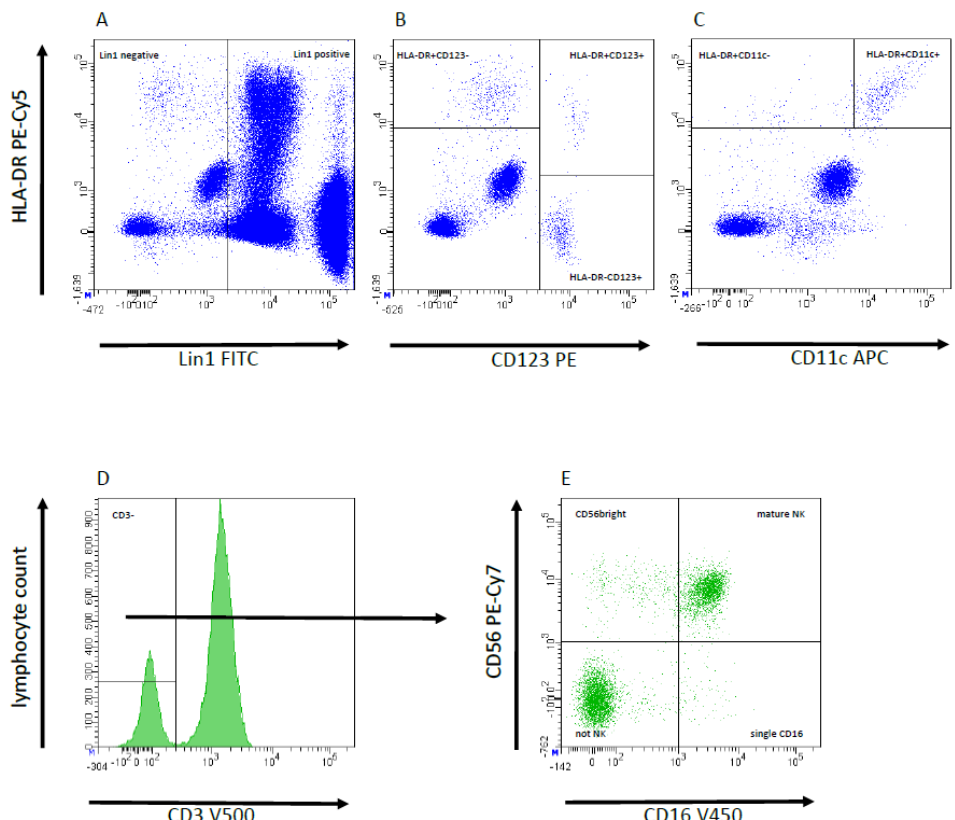
Figure 1. Representative flow cytometry plots from peripheral blood samples to demonstrate gating strategy; typical example illustrating the peripheral blood cell composition with flow cytometric analysis and gating strategy. The antibody cocktail Lin1 includes markers for all leucocyte subtypes, except dendritic cells. Based on lin1-negative cells ( A ) plasmacytoid dendritic cells (pDC) are shown as cells which are HLA-DR + CD123 + AND HLA-DR + CD11c − ( B , C ). In contrast, myeloic dendritic cells (mDC) are HLA-DR + CD123 − AND HLA-DR + CD11c + ( B , C ). To exclude T cells and NK-T cells, all CD3-cells were separated ( D ). Using antibodies against CD16 and CD56, these cells can be divided CD56 bright, mature NK and single CD16 NK cells. CD16/CD56 double negative were not NK cells (e.g., ( B ) cells), ( E